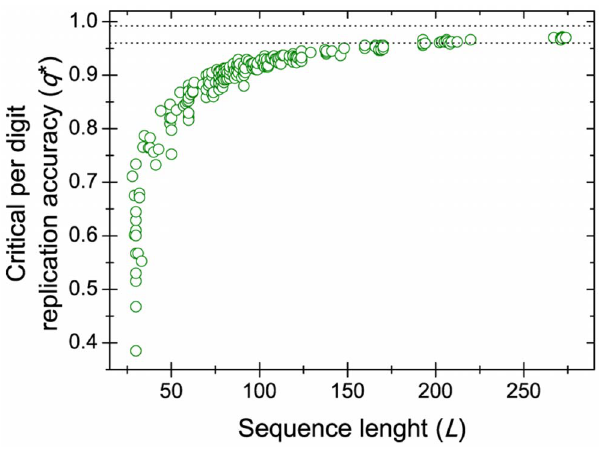
Figure 4. Error threshold of real ribozymes and aptamers. Critical per digit replication accuracy required to replicate real ribozymes and aptamers, calculates using Eq. (2). Each point represents a ribozyme or an aptamer (see Table S1). The two dotted lines mark the zone of replication accuracy of putative RNA-dependent RNA polymer- ases (0.96 , q , 0.99).